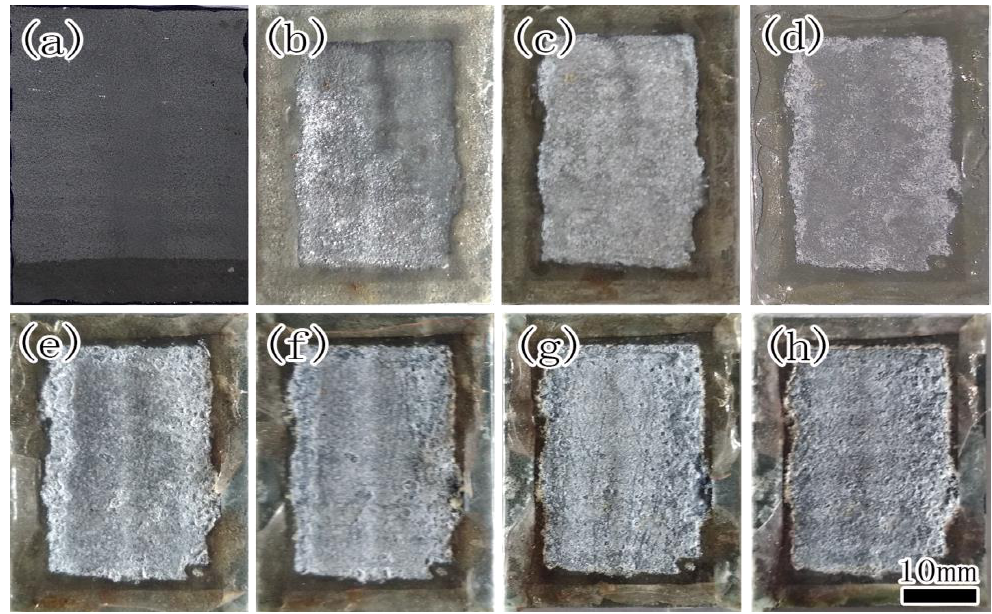
Figure 4. The optical photographs of the composite coating during salt spray test after ( a ) 0 days; ( b ) 10 days; ( c ) 15 days; ( d ) 25 days; ( e ) 50 days; ( f ) 100 days; ( g ) 150 days; ( h ) 200 days.